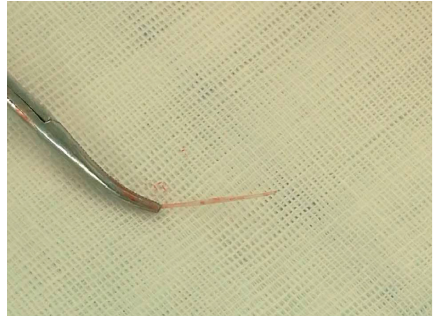
Figure 2: The picture of the fish bone. The fish bone with a sharply pointed tip was grasped and pulled out by the mosquito forceps. The length was about 2.45cm.